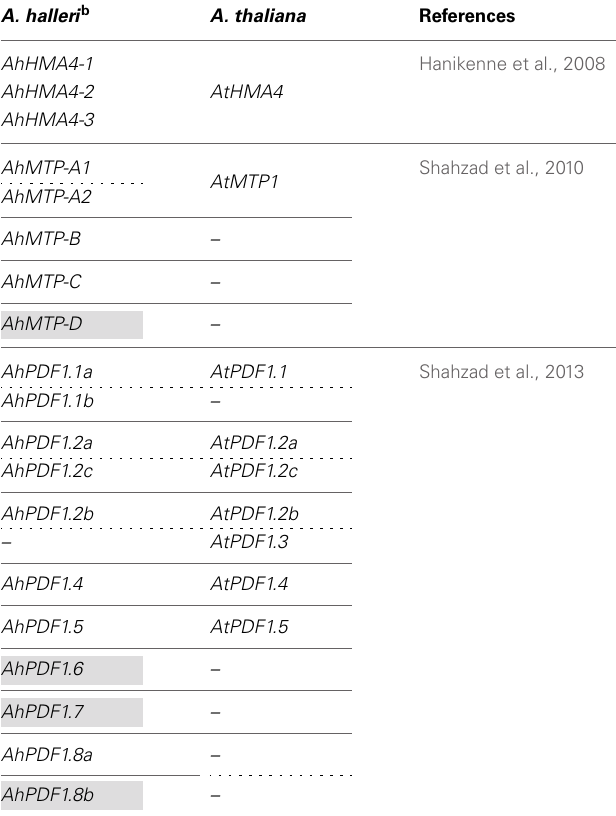
Table 1 | Comparative genomic organization of some genes recognized for their high constitutive transcript accumulation in A. halleri as compared to A. thaliana a